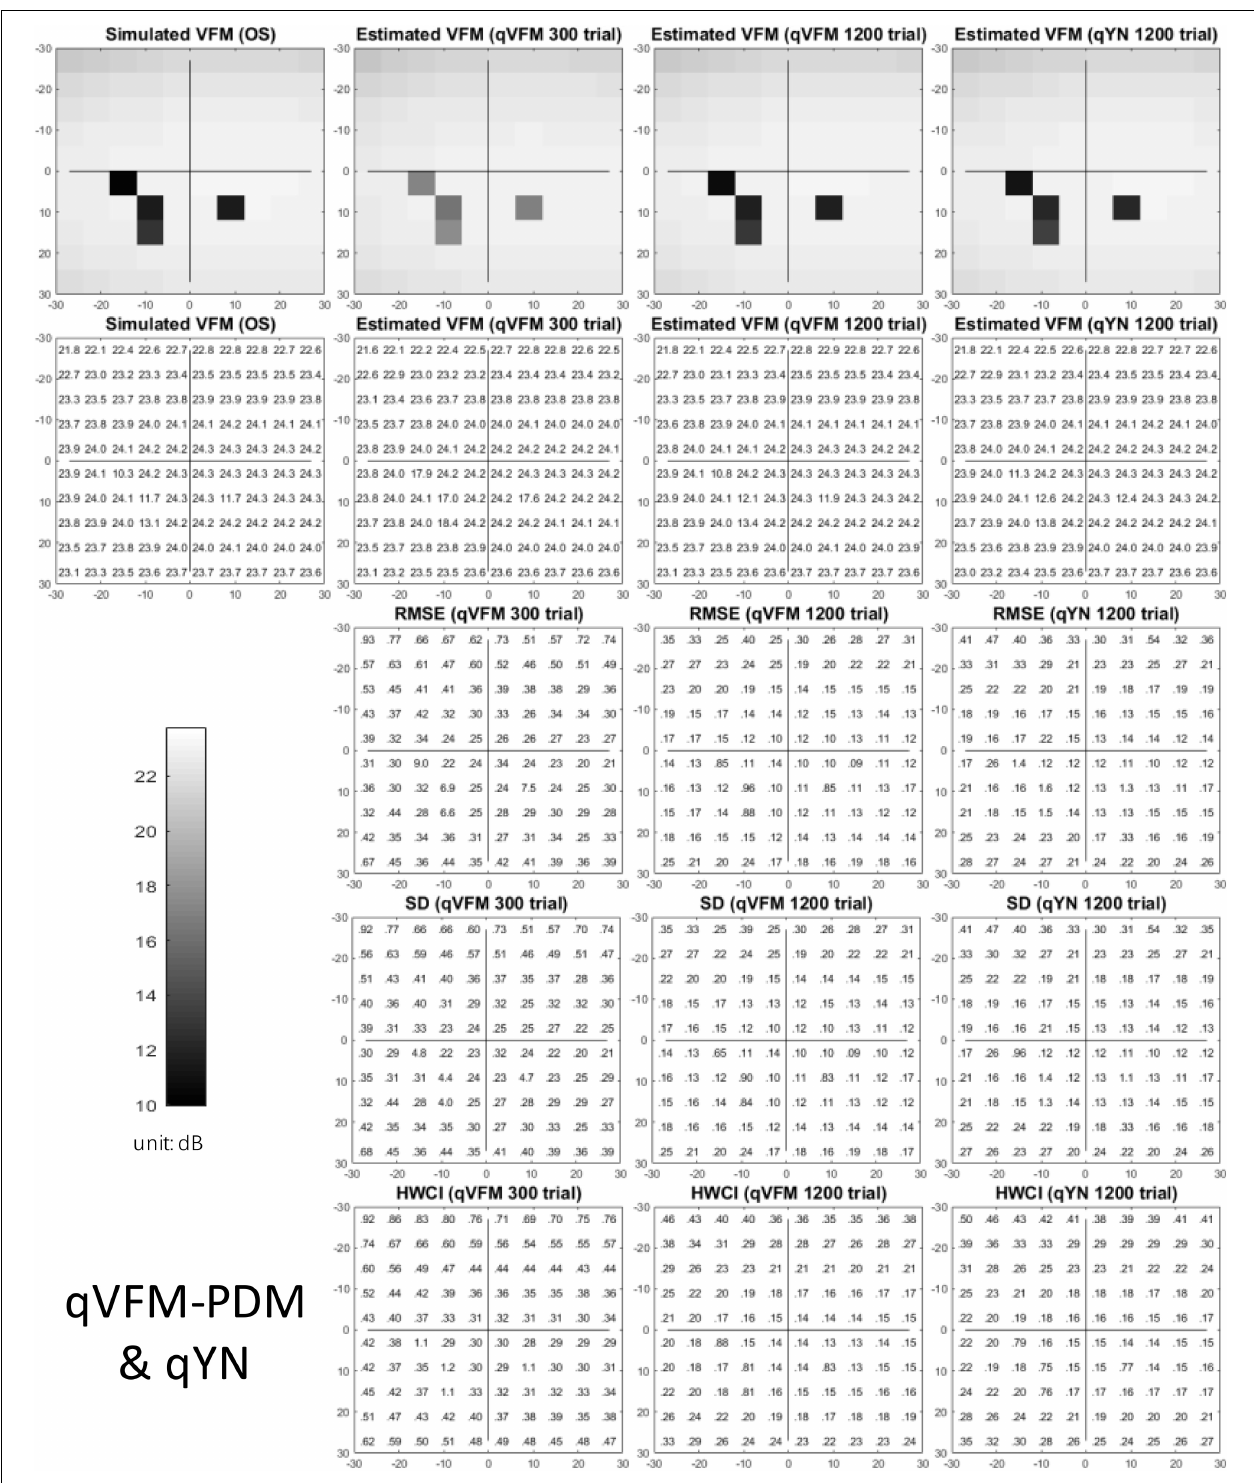
Frontiers in Neuroscience |